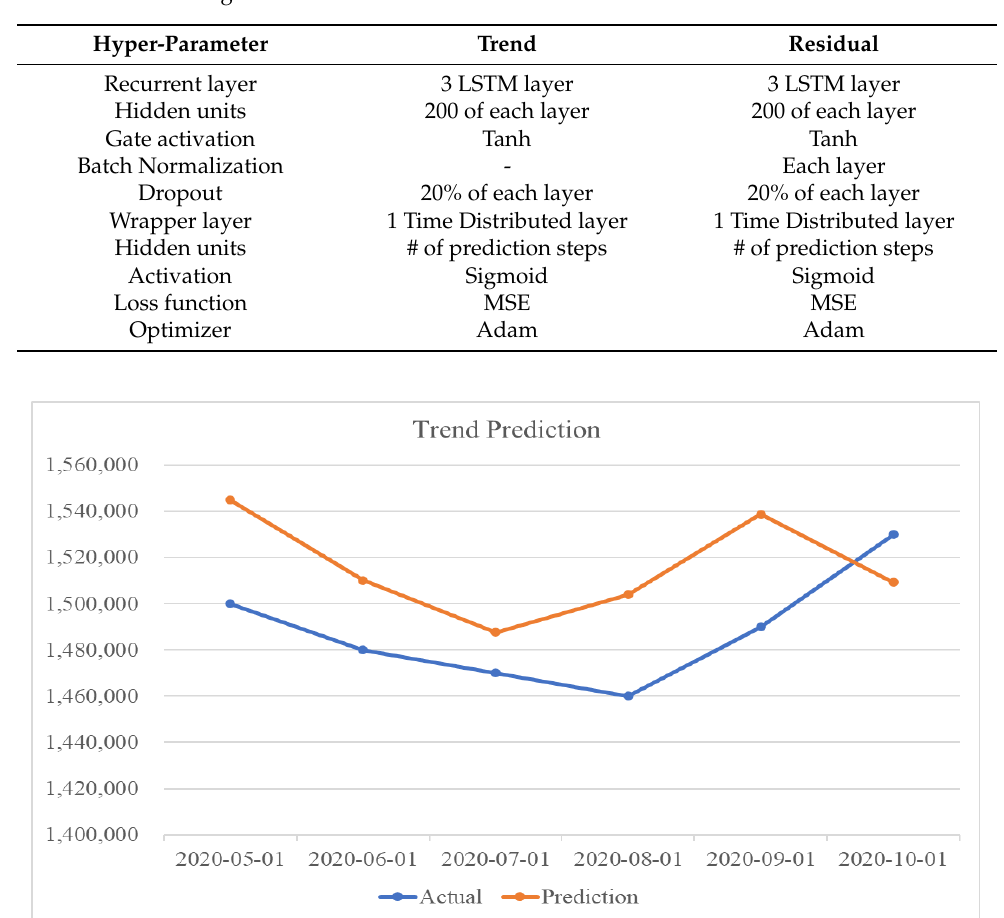
Figure 8. Trend prediction (x: data, y: TEU).